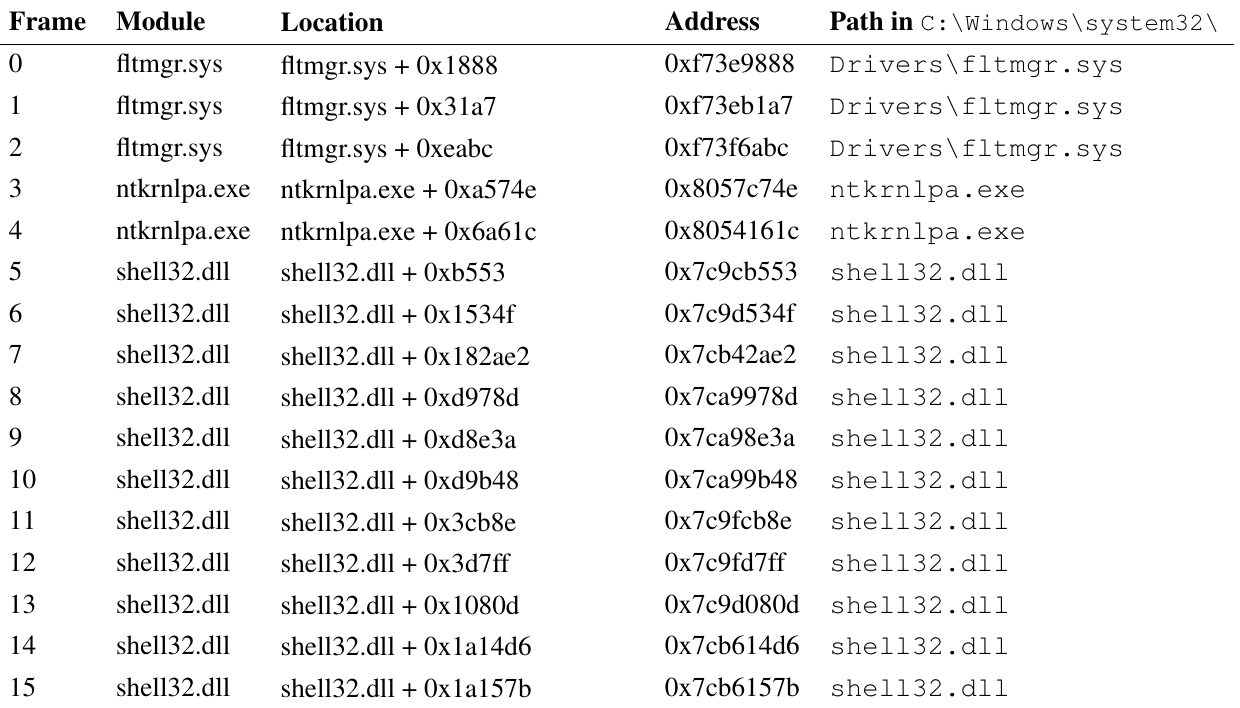
Table 7. Confusing function calls in services.exe